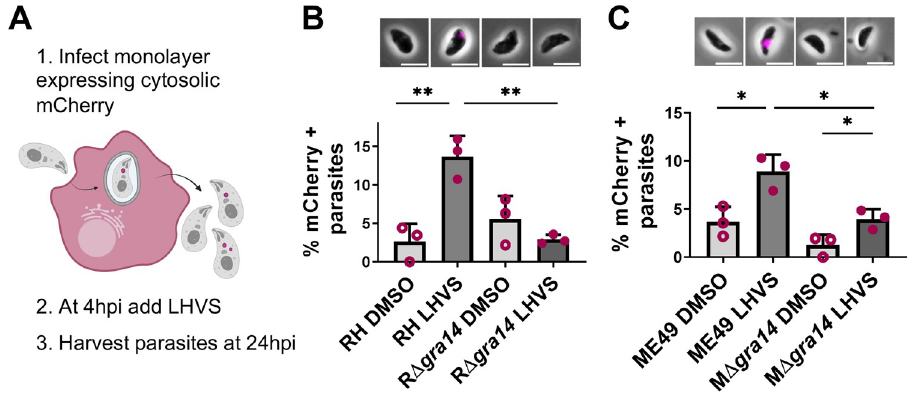
Fig 6. Replicating parasites deficient of TgGRA14 do not internalize host cytosolic proteins as efficiently as wildtype. A. Experimental design for the analysis of the internalization of host cytosolic proteins of TgGRA14-deficient parasites. (1) Inducible mCherry HeLa cells were infected with parasites for 4 hours, (2) at 4 hpi, extracellular parasites were removed, and the infected monolayer was treated with LHVS for 20 h, (3) parasites were harvested at 24 hpi and analyzed by microscopy. B. Quantification of host cytosolic mCherry uptake at 24 hpi by RH or R Δ gra14 type I strains treated with DMSO or LHVS for 20 h. C. Quantification of host cytosolic mCherry uptake at 24 hpi by ME49 or M Δ gra14 type II strains treated with DMSO or LHVS for 20 h. At least 200 parasites were analyzed per blinded sample. Data represents the mean from � 3 biological replicates. Statistical analysis was by Student’s t-test. � p < 0.05, �� p < 0.01, ��� p <